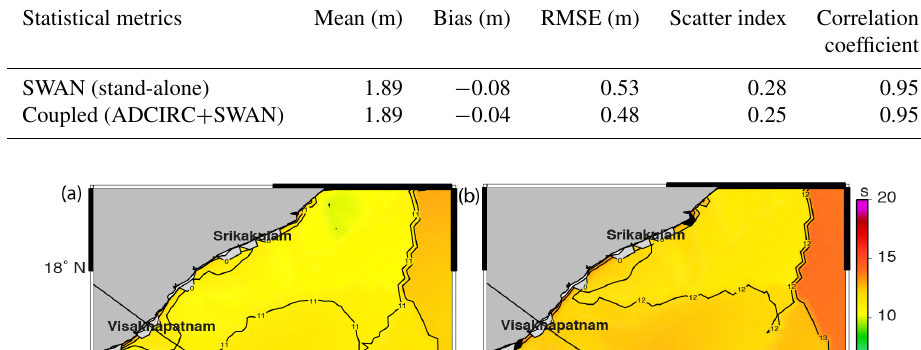
Table 1. Statistical measures with (coupled) and without (stand-alone) currents on waves at the buoy location.